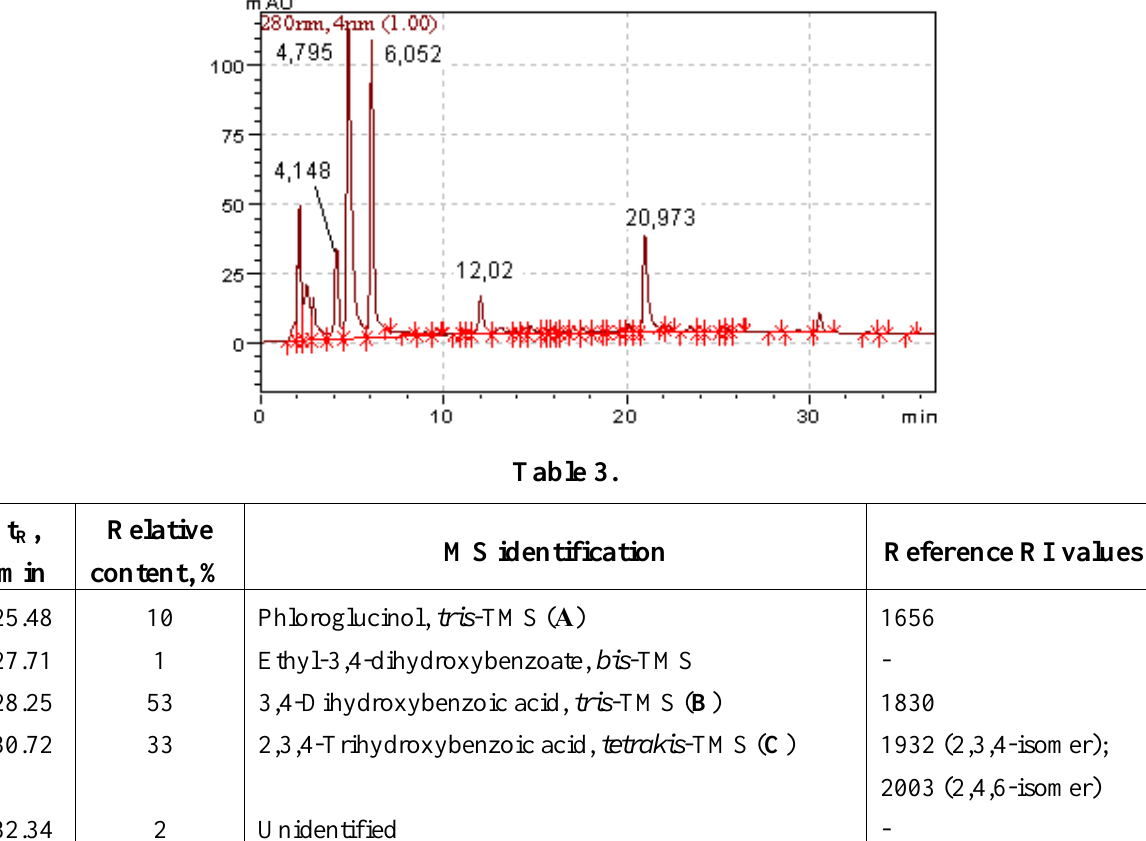
Figure 4. HPLC chromatogram (regime 2) of dried quercetin oxidation products (initial compound with t 25.68 min is absent). Component with t R glucinol; 4.890 min – 2,4,6-trihydroxybenzoic acid; 6.05 min – 3,4- dihydroxybenzoic acid; 12.02 – intermediate depside ( 2 ); 20.97 min – unidentified compounds. Each peak is 100 % pure as there is no co-elution of